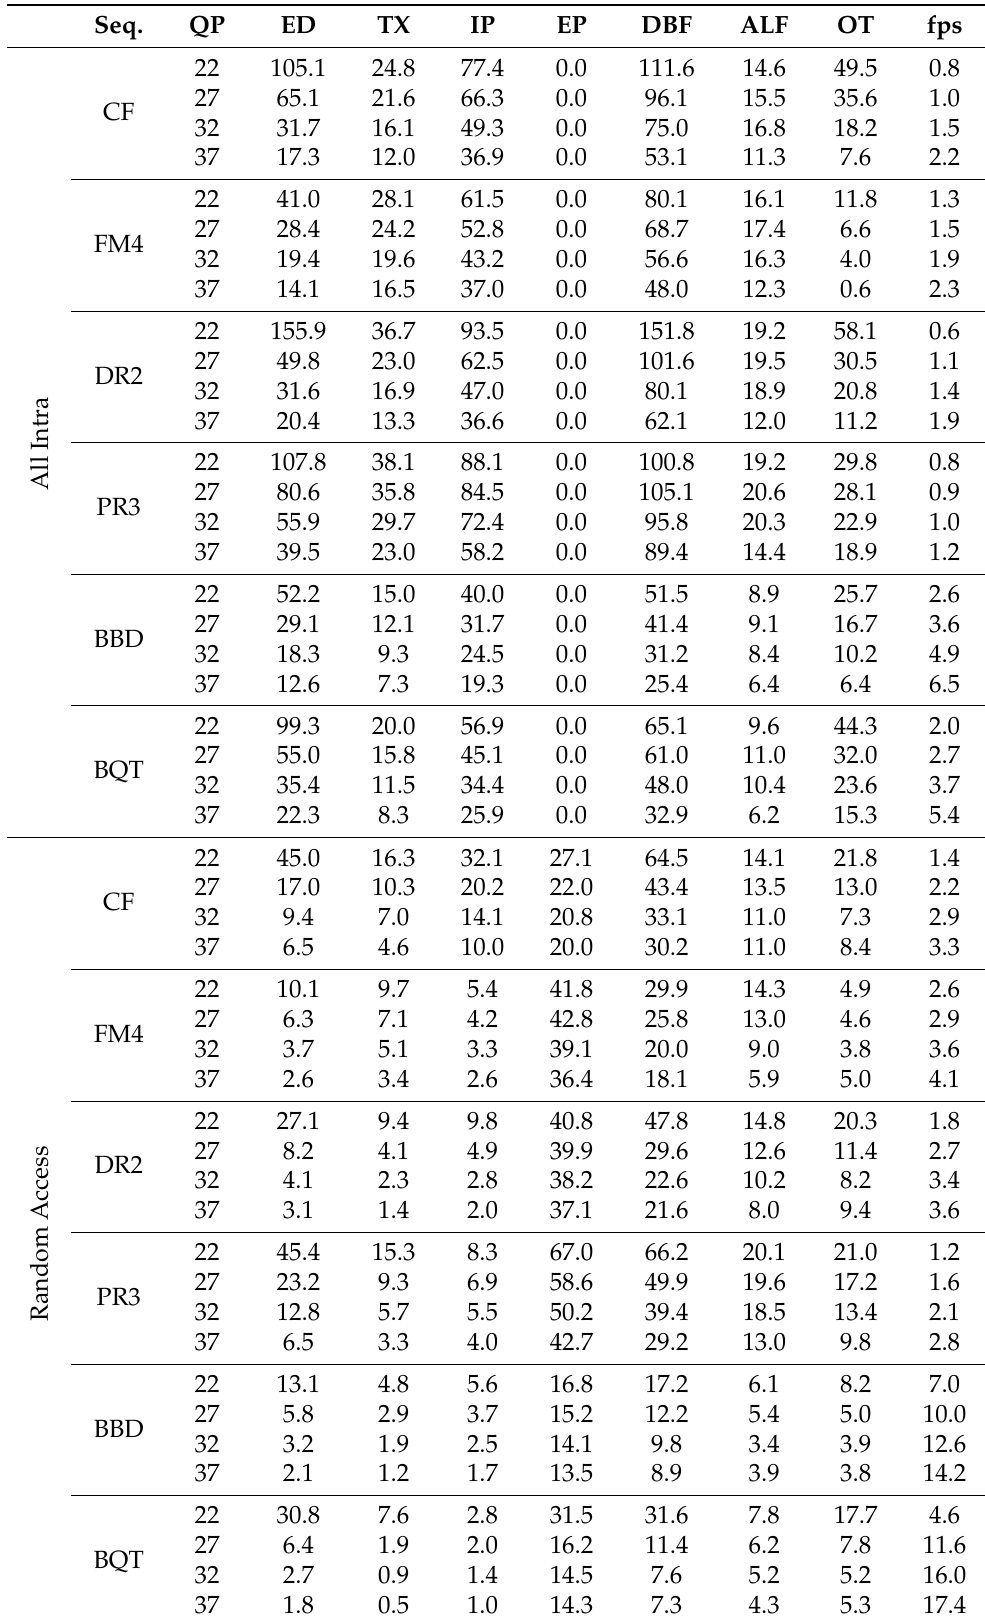
Table 2. Processing times (in s) for each decoding block and global fps achieved over the HGPP.